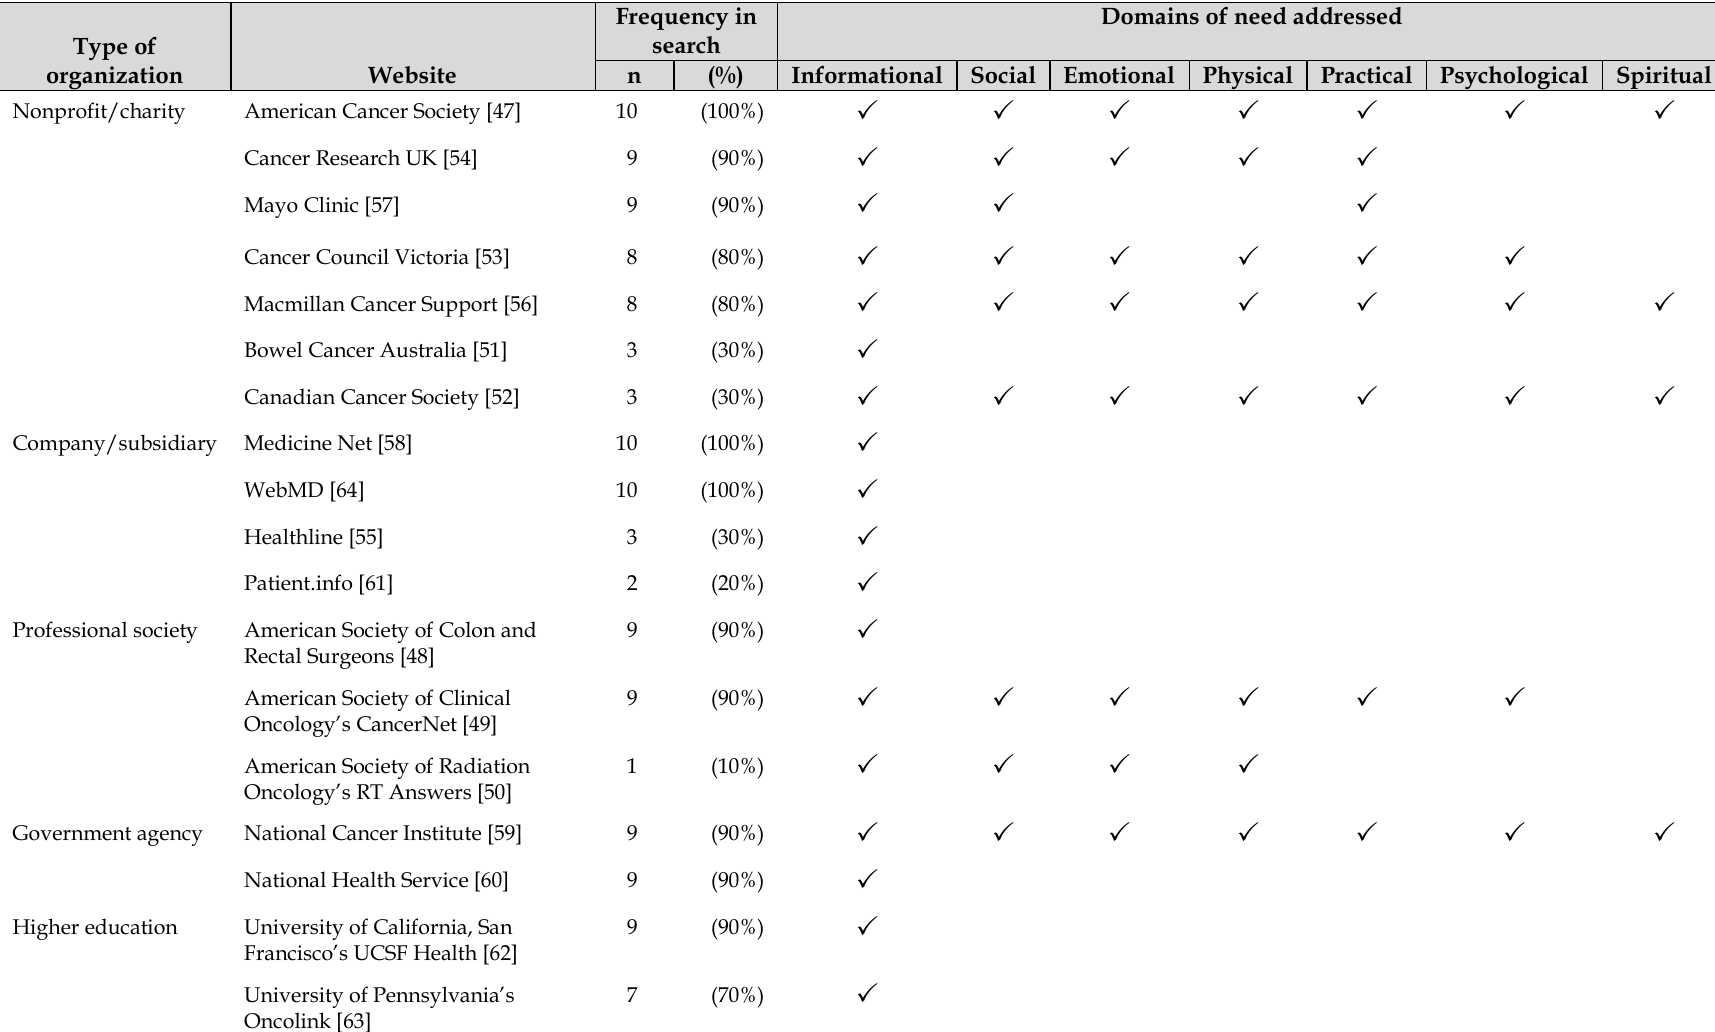
Table 2 Website frequency and supportive care needs domains addressed Type